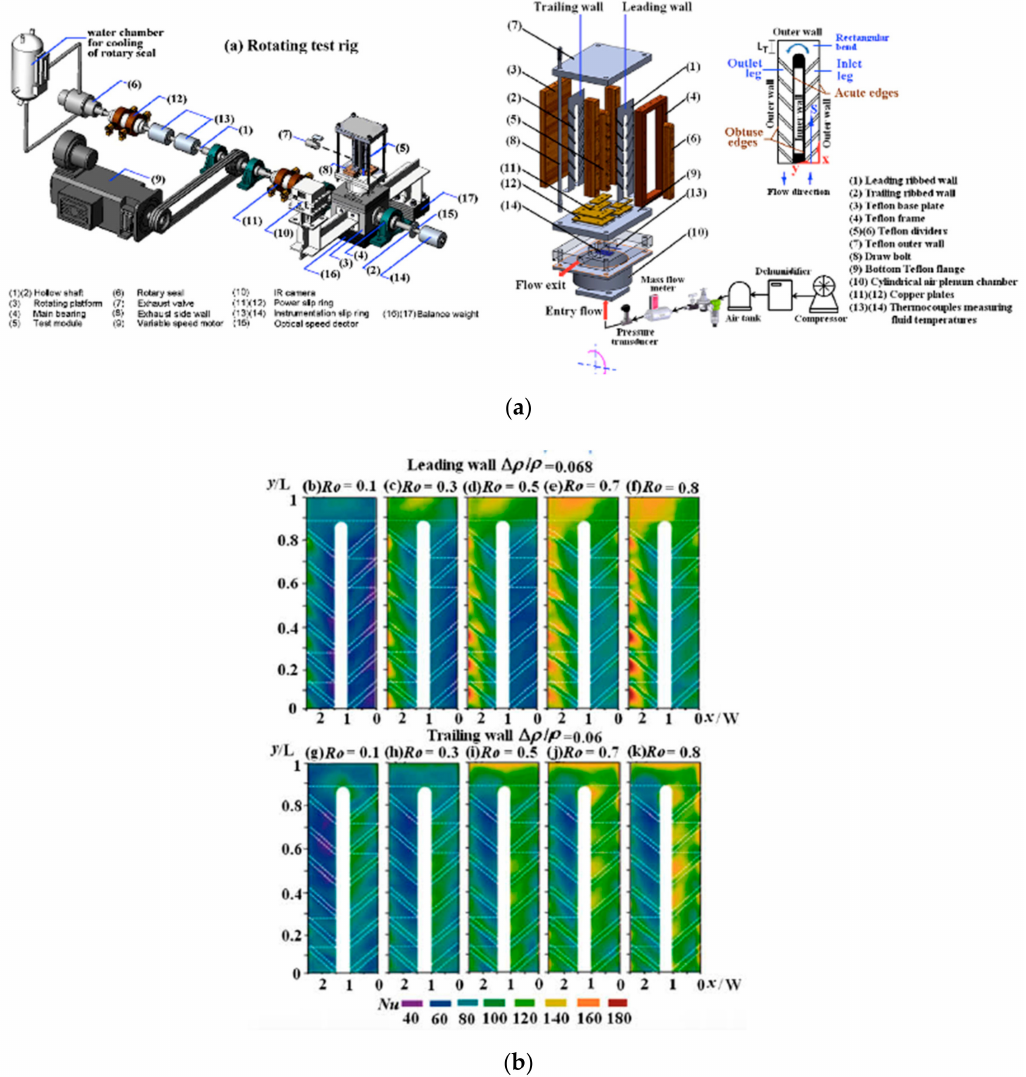
Figure 10. ( a ) Rotating rig facility employing Infrared thermography by Chang et al. [36], ( b ) detailed Nusselt number ratio ( Nu / Nu 0 ) ratio under rotating conditions (Ro varied from 0.1 to 0.8) Reprint with permission from Elsevier (order number